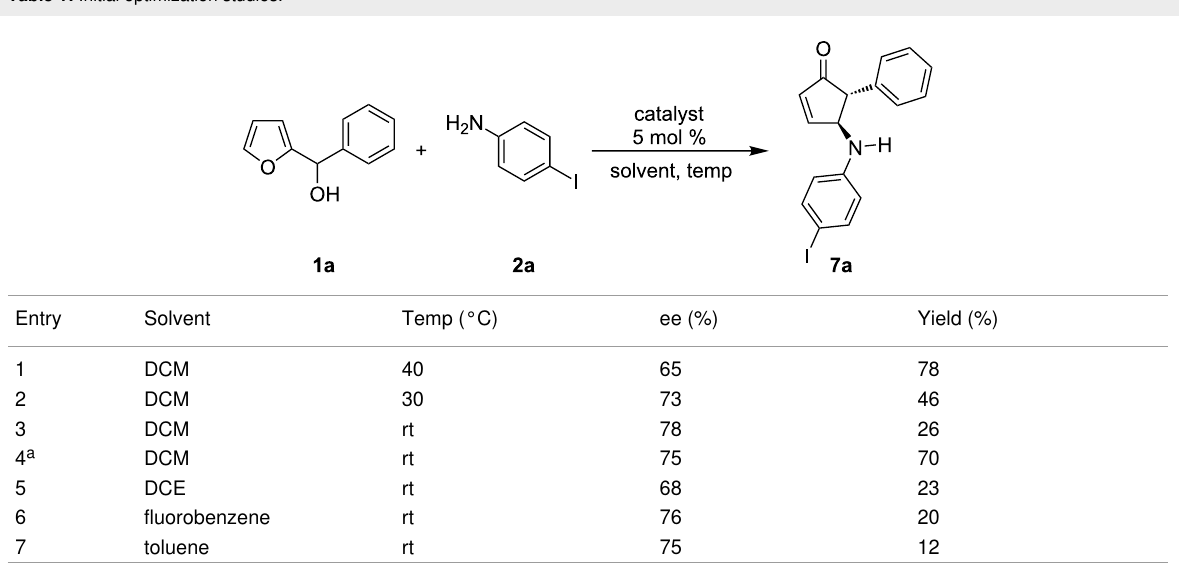
Table 1: Initial optimization